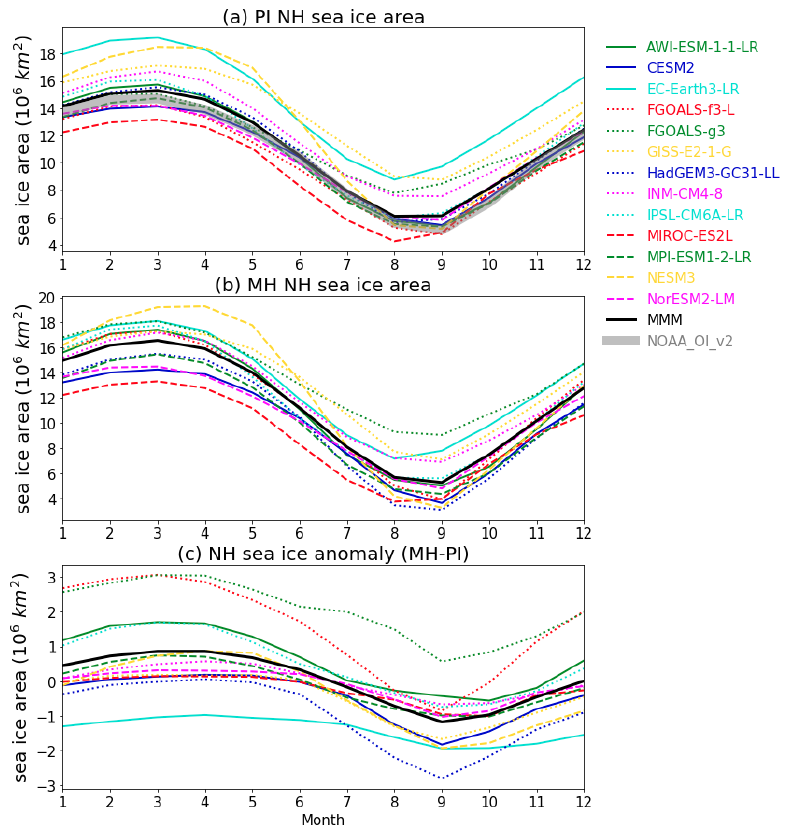
Figure 17. The Arctic annual cycle of area of sea ice greater than 15% (10 6 km 2 ) for the (a) PI, (b) MH for a subset of the models. Note that 14 models completed both the midHolocene and lig127k experiments. Three models: ACCESS-ESM1-5, AWI-ESM-2-1-LR, CNRM-CM6-1 completed only the lig127k